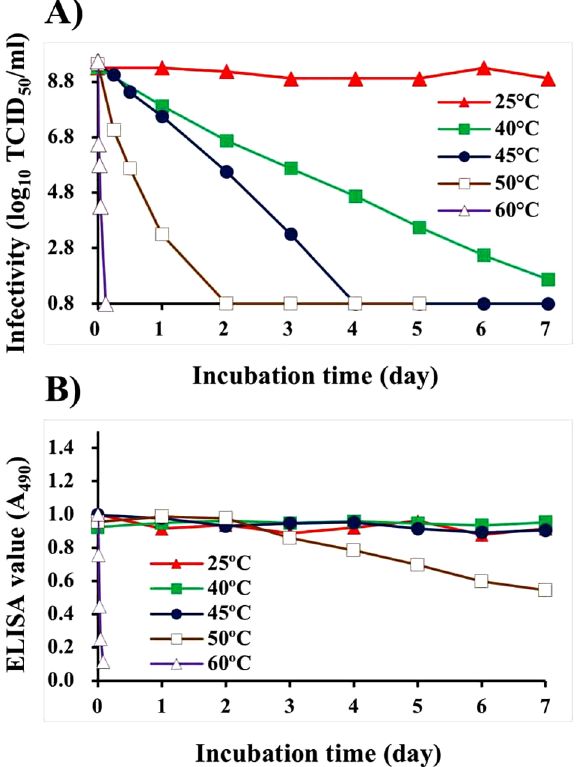
Figure 1. Effect of incubation at different temperatures on infectivity and antigenicity of cultured NNV suspensions. Cultured NNV suspensions were incubated at 25 °C, 40 °C, 45 °C, 50 °C, or 60 °C for up to 7 days. After incubation, each sample was subjected to titration of NNV infectivity and ELISA for detecting NNV antigens. ( A ) NNV infectivity, ( B ) NNV